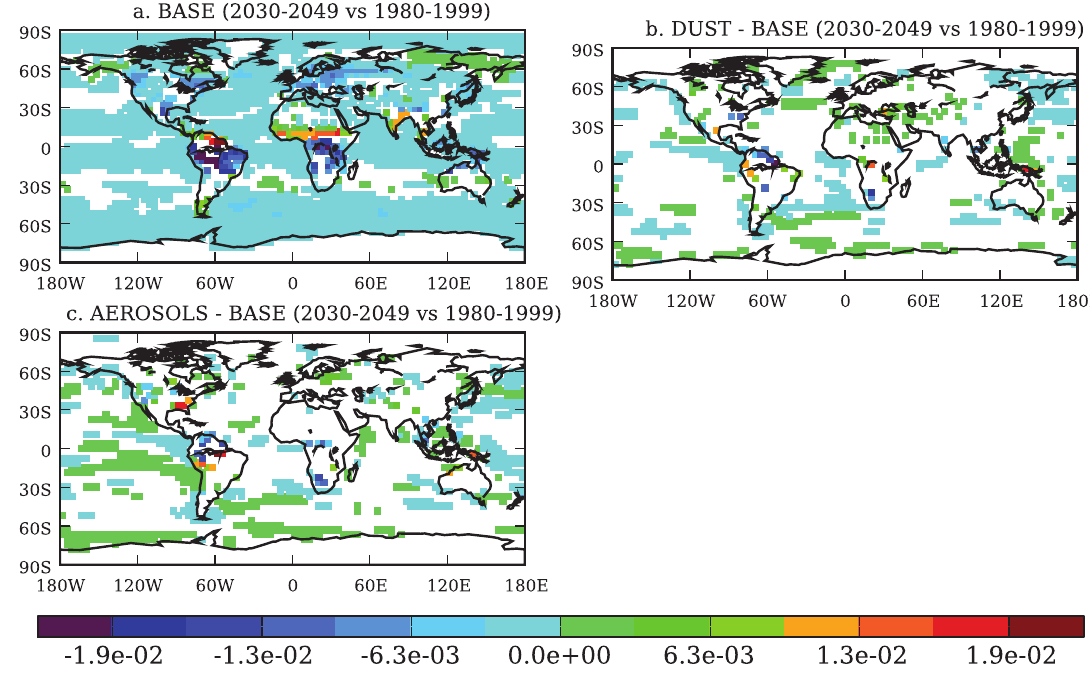
Fig. A4. Same as Fig. A3, but for surface CO 2 fluxes (mg CO 2 m − 2 s ◦